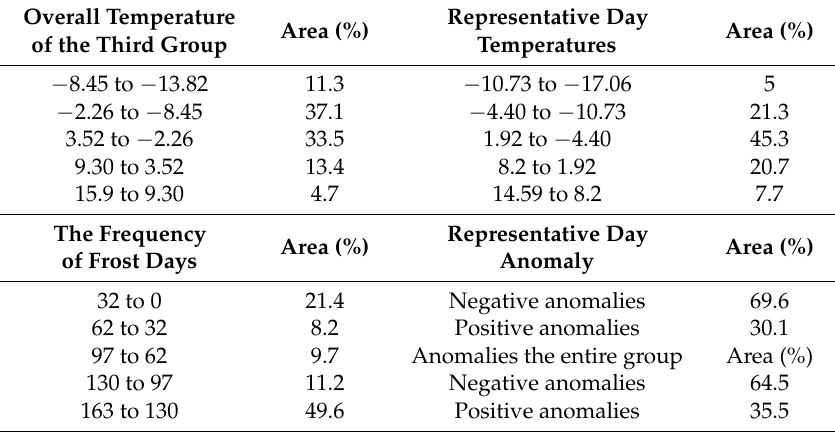
Table 4. Percentage of the covered area of different classes of average temperature, anomalies and frequency of frosts for the third